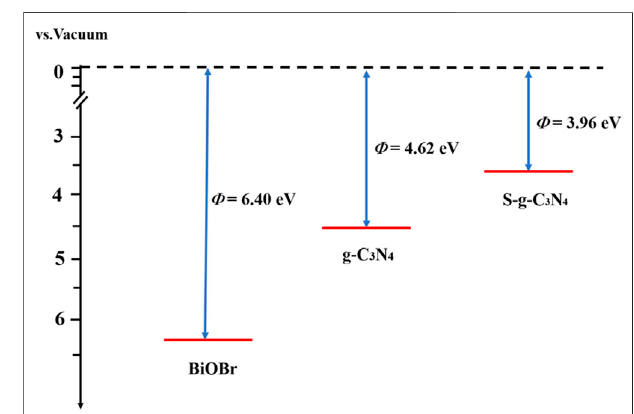
FIGURE 3 | The calculated work functions of BiOBr, g-C 3 N 4, and S-g- C 3 N 4 . The red and black dotted lines signify the Fermi level and vacuum energy level, respectively.